Question: Write a single sentence explaining what this figure depicts.
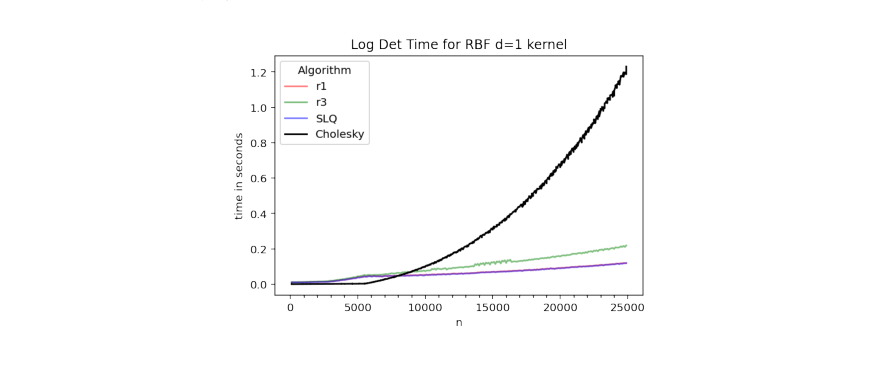
Answer: Comparison of log det algorithms as a function of n on the radial basis function kernel with d = 1 as measured on a NVidia A100 GPU. All measurements are averages over 100 randomly generated kernels.